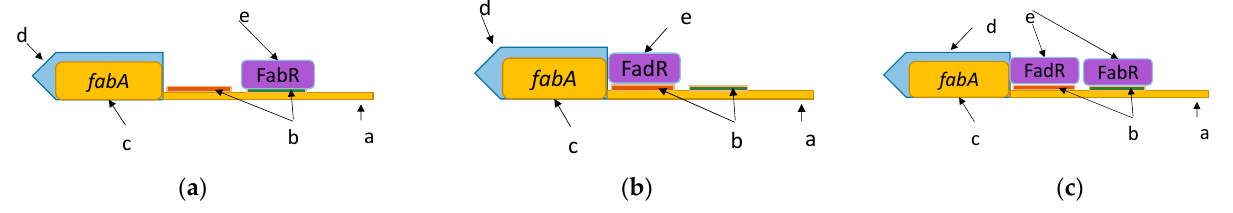
Figure 5. Binding options for a TF where a—operon’s promotor region; b—TFBSs; c—gene; d— operon; e—TF: ( a ) FabR binds to a site; ( b ) FadR binds to a site; ( c ) FabR and FadR bind simultane- ously.